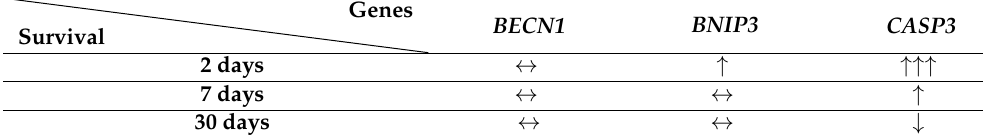
Table 2. Changes in the expression of autophagy ( BECN1) , mitophagy ( BNIP3 ), and apoptosis ( CASP3 ) genes in the CA1 area of hippocampus at different times after experimental brain ischemia. Genes BECN1 BNIP3 CASP3 Survival 2 days ↔ ↑ ↑↑↑ 7 days ↔ ↔ ↑ 30 days ↔ ↔ ↓ Expression: ↑ Increase; ↓ decrease; ↔ oscillation around control